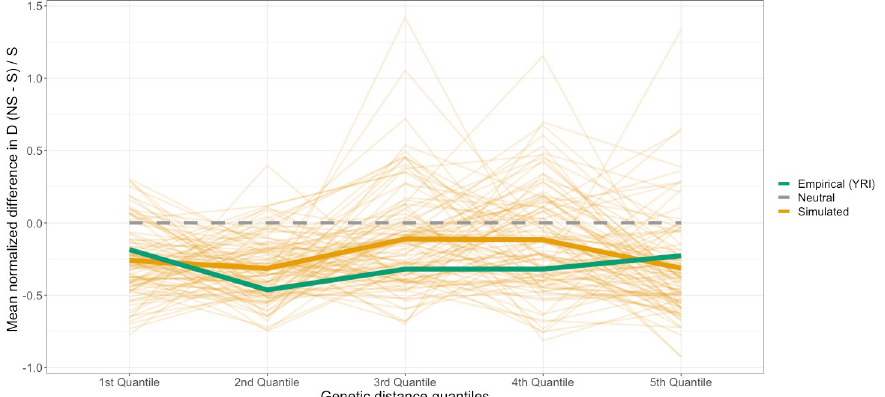
Fig 6. Mean normalized difference in D across genetic distance quantiles. Empirical (green) and simulated data shows a deficit in D between NS variants. The lighter orange lines show 100 resamples of the simulated data. Each resample of the simulated data has the same number of variants with the same allele count as the empirical data.